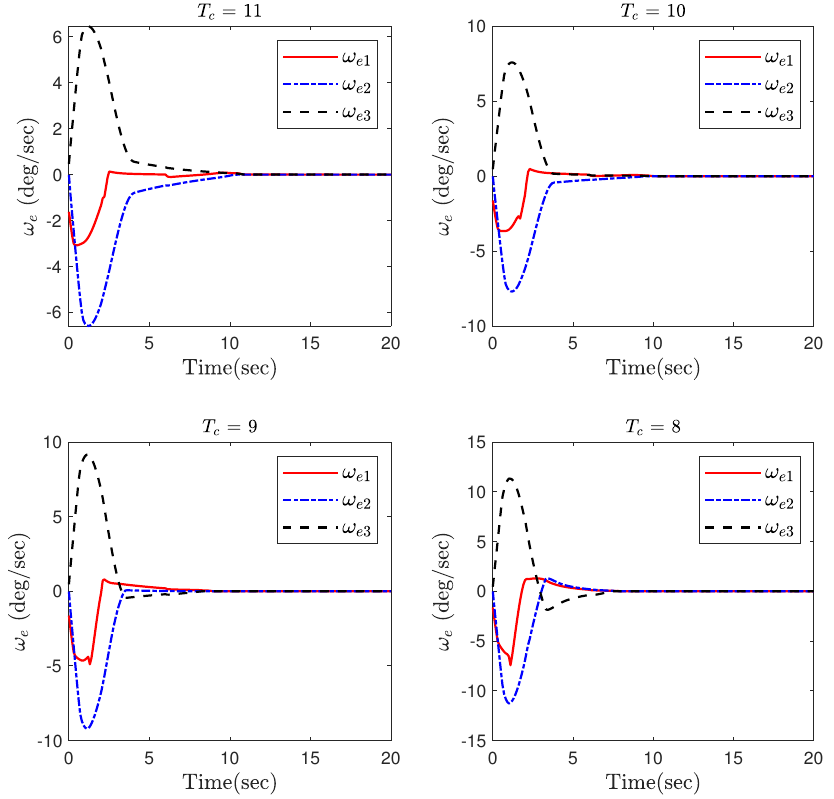
Figure 9. The angular velocity tracking error in Part